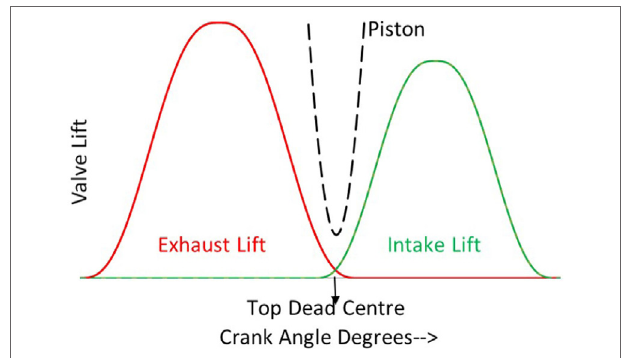
FigUre 3 | Intake and exhaust valve profiles with a conventional cam